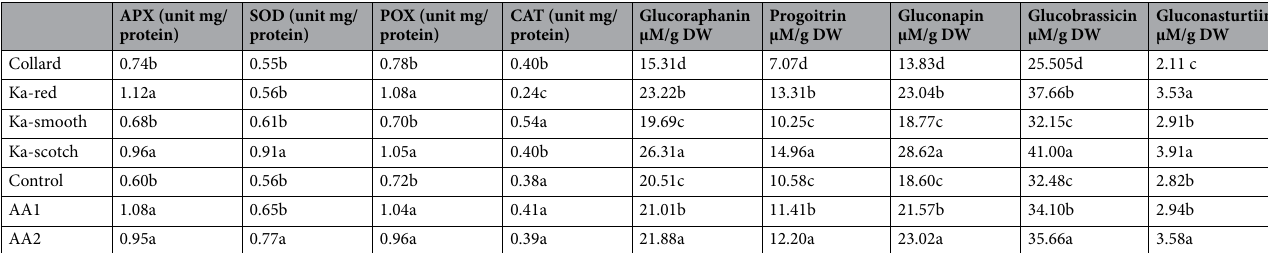
Table 4. The main effect of AA and cultivar on some antioxidant and glucosinolate contents of cabbages. Control control treatment, AA1 150 mg/L of amino acid, AA2 150 and 300 mg/L of amino acid, APX ascorbate peroxidase, SOD superoxide dismutase, POX peroxidase, CAT catalase. Within a column in each treatment means followed by the same letter are not significantly different at P < 0.05 according to the least significant difference test.